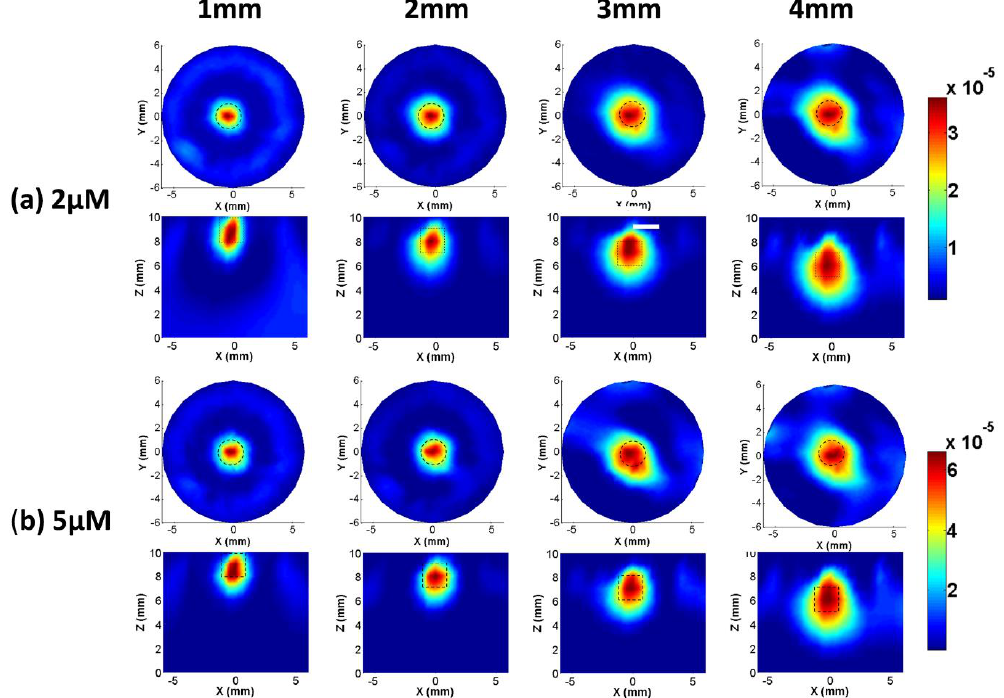
Figure 2. Fluorescence molecular tomography (FMT) images for a target having different indocyanine green (ICG) concentrations (( a ) 2µM and ( b ) 5 µM) at different depths (1 mm to 4 mm).